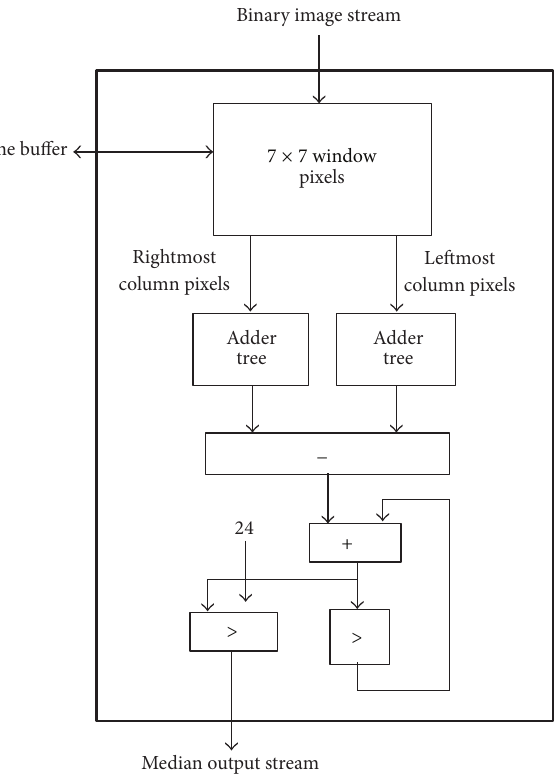
Figure 10: Hardware architecture of median